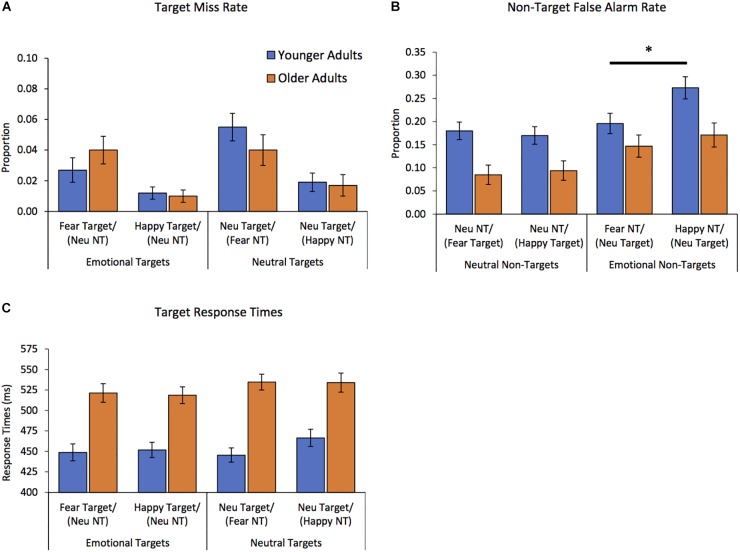
Results of Go/No-go task by outcome measure and age group. Each block contained 35 targets and 13 non-targets. (A) Target miss rate. There were more misses for neutral targets than emotional targets, and more misses in blocks with fearful faces than happy faces. There were no effects of age on target miss rate. (B) Non-target false alarm rate. Younger adults had more false alarms than older adults. There were more false alarms to happy than fearful non-targets, but false alarms to neutral non-targets did not differ between blocks with fearful vs. happy target faces. Interactive effects revealed only younger adults had significantly greater false alarms to happy than fearful non-target faces (denoted with black bar). ∗p < 0.0005, d = 0.59. (C) Target response times. Responses were faster to emotional targets than neutral targets, and younger adults were faster to respond to targets than were older adults. There were no differences between response times within blocks containing happy vs. fearful faces. Target = “Go” stimulus. NT = non-target “No-go” stimulus. Neu = neutral. Error bars represent standard error of the mean (SEM).